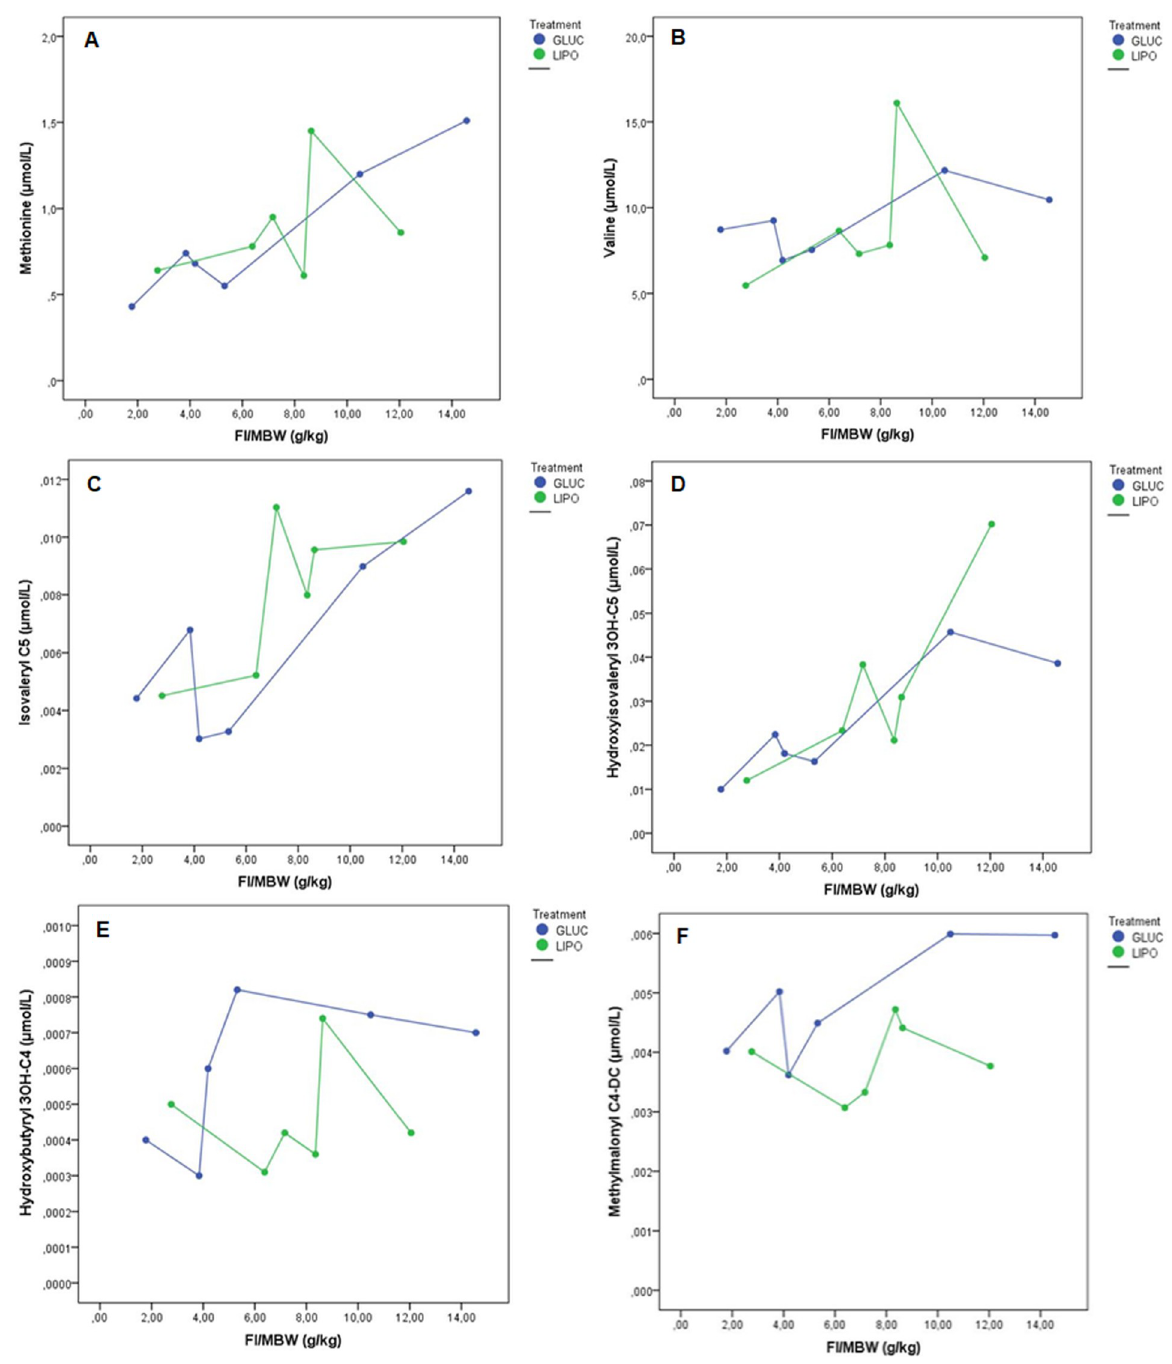
Fig 4. Metabolites related to amino acid catabolism in adult Xenopus laevis fed isoenergetic glucogenic (GLUC) or lipogenic (LIPO) diets. FI: Food intake, MBW: metabolic body weight. A: Methionine, B: Valine, C: Isovaleryl, D: Hydroxyisovaleryl, E: Hydroxyisobutyryl, F: